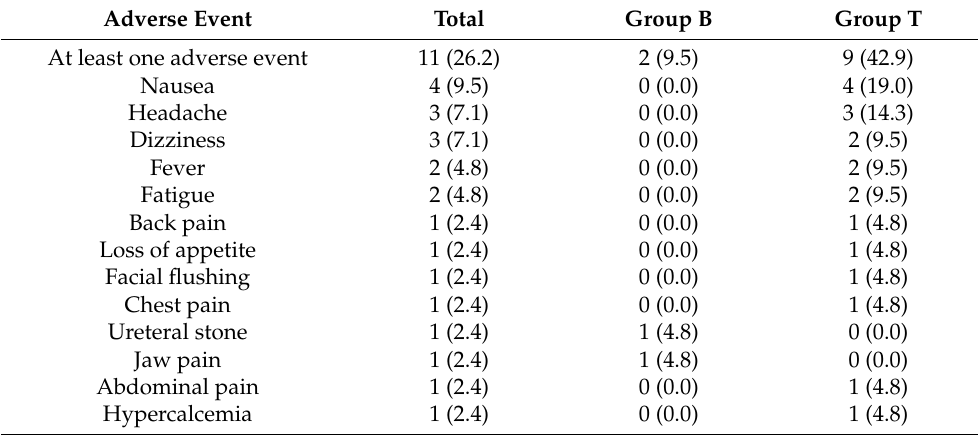
Table 3. Causally related adverse